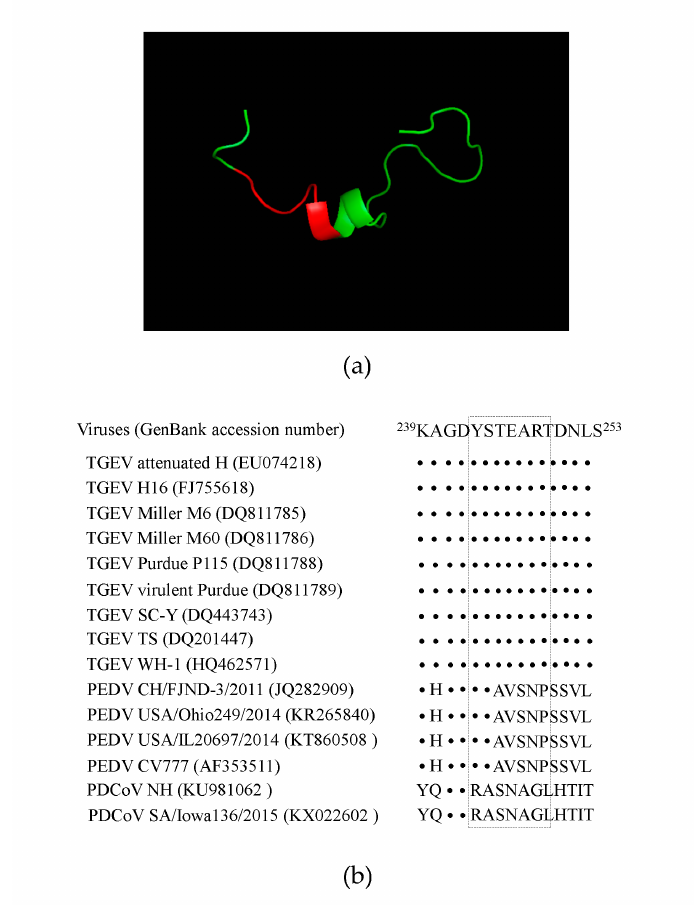
Figure 3. Location of the identified epitope in the predicted structure of the TGEV M protein. ( a ) The location of the epitope (shown in red) for mAb 1C3 (YSTEART) in the TGEV M protein is highlighted; ( b ) Conservation of the M epitopes (YSTEART) in TGEV, porcine epidemic diarrhea virus (PEDV) and porcine deltacoronavirus (PDCoV). Dots indicate identical